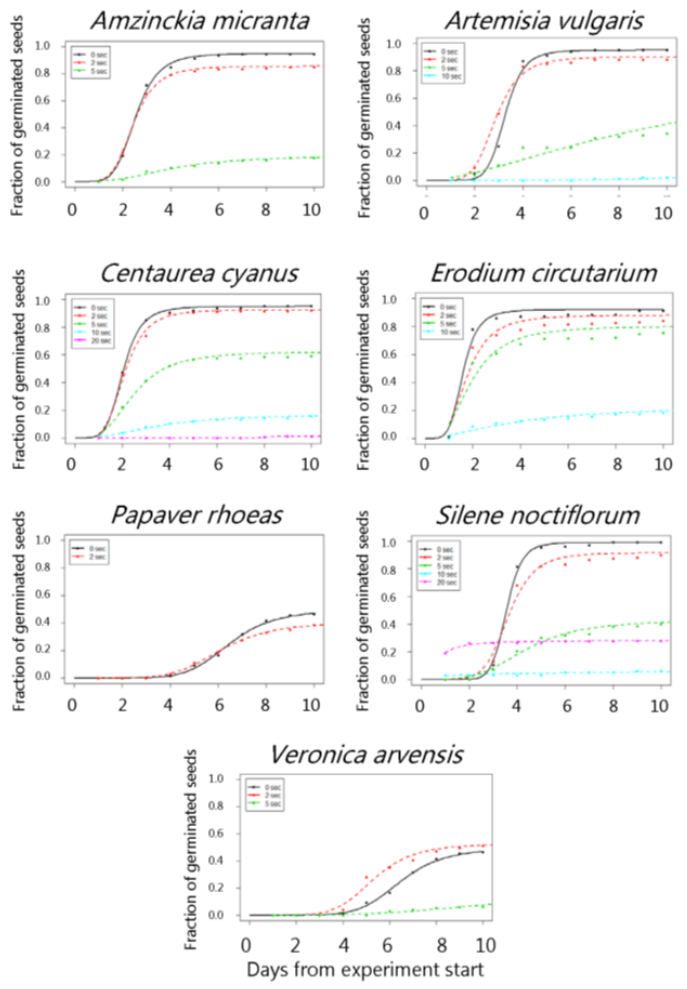
Figure 4. Germination curves of seed lots of seven weed species exposed to 250 °C at various durations. Table 3. Weed species and treatments (temperatures and durations) and estimates of the germination percentage (standard error). “-“ means that no seeds germinated or too few seeds germination to estimate a germination curve. Species Temperature 0 s 2 s 5 s 10 s 20 s